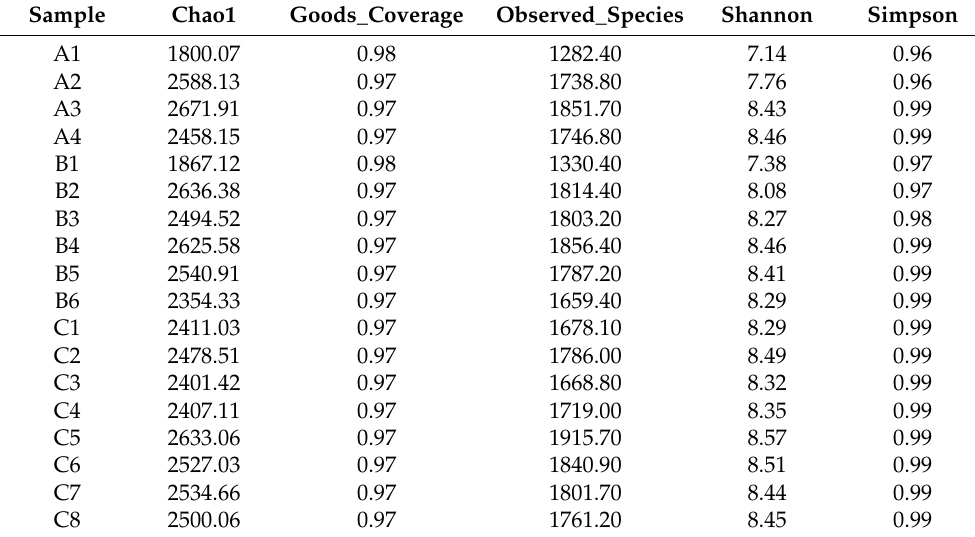
Table 3. Statistical data of the alpha diversity